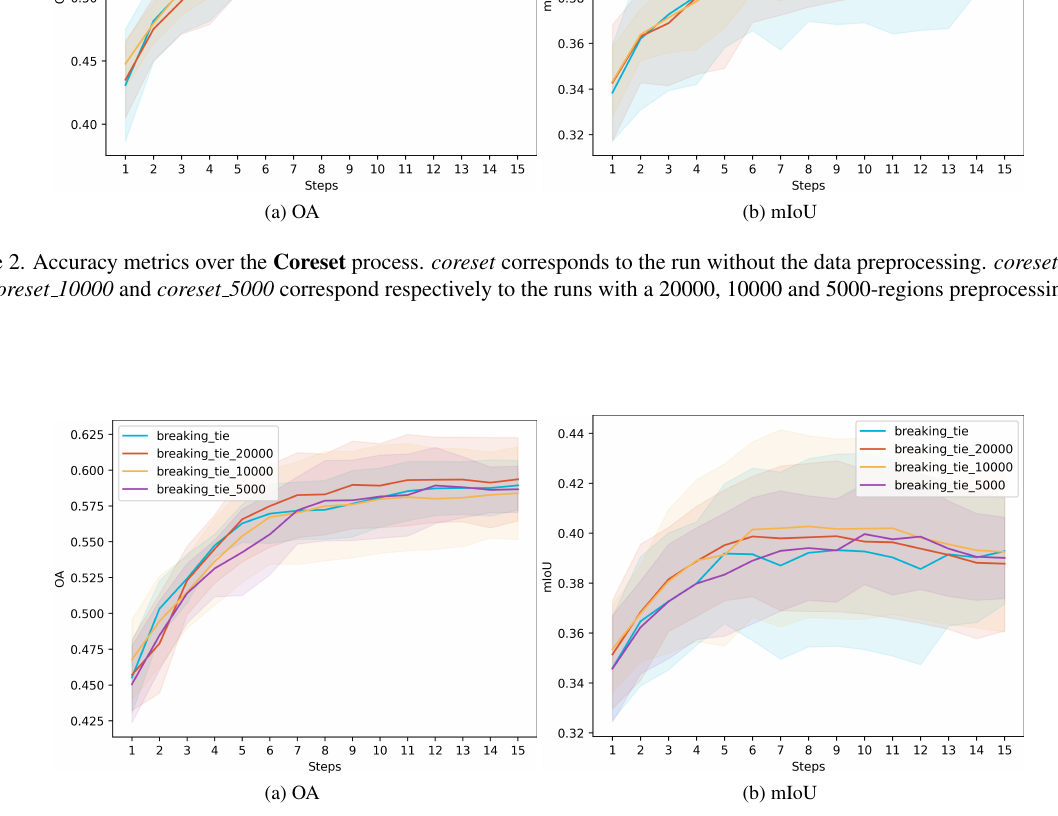
Figure 3. Accuracy metrics over the Breaking Tie process. breaking tie corresponds to the run without the data preprocessing. breaking tie 20000 , breaking tie 10000 and breaking tie 5000 correspond respectively to the runs with a 20000, 10000 and 5000-regions preprocessing.